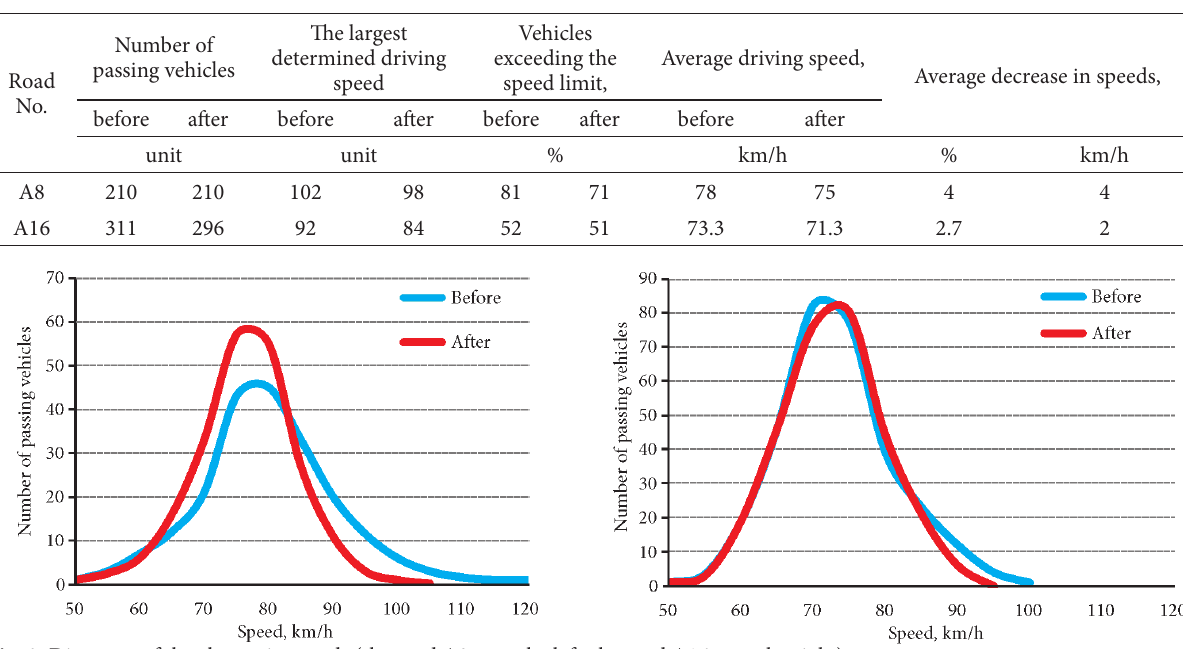
Table 3. Data on measuring the change in speeds